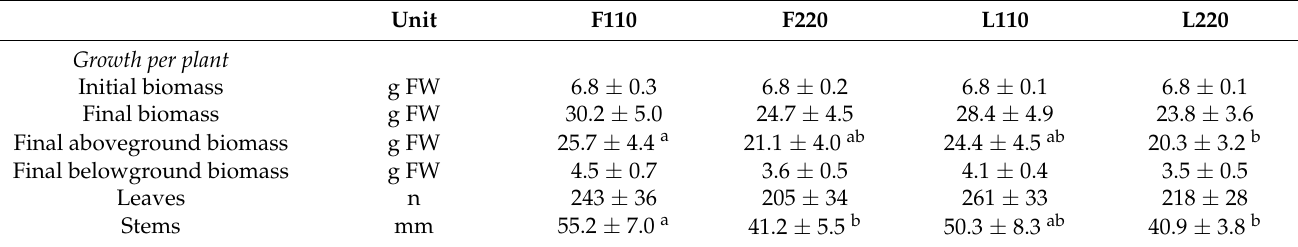
Table 2. Growth parameters (mean ± s.d.) of H. portulacoides hydroponic units ( n = 5). FW—fresh weight. Different letters ( a , b , c ) indicate significant differences between treatments ( p <